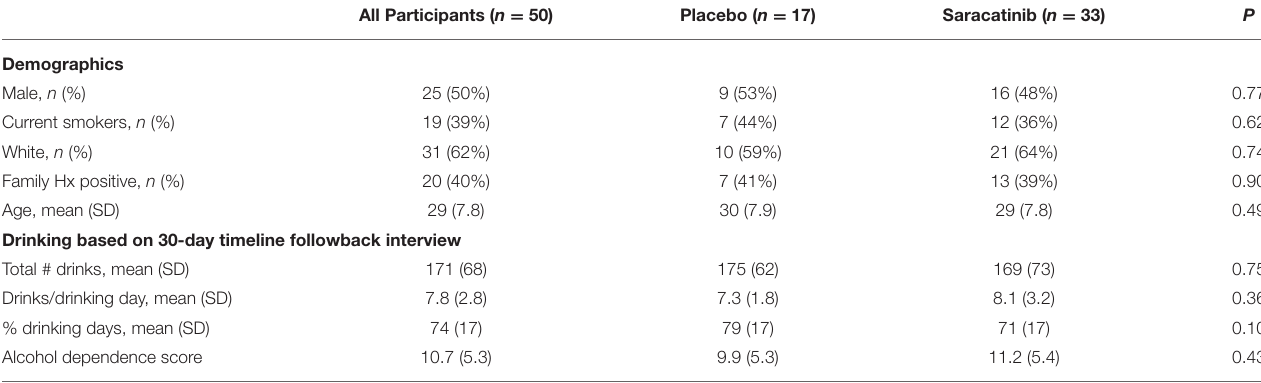
TABLE 1 | Participant demographics and drinking histories. All Participants ( n = 50) Placebo ( n = 17) Saracatinib ( n = 33)